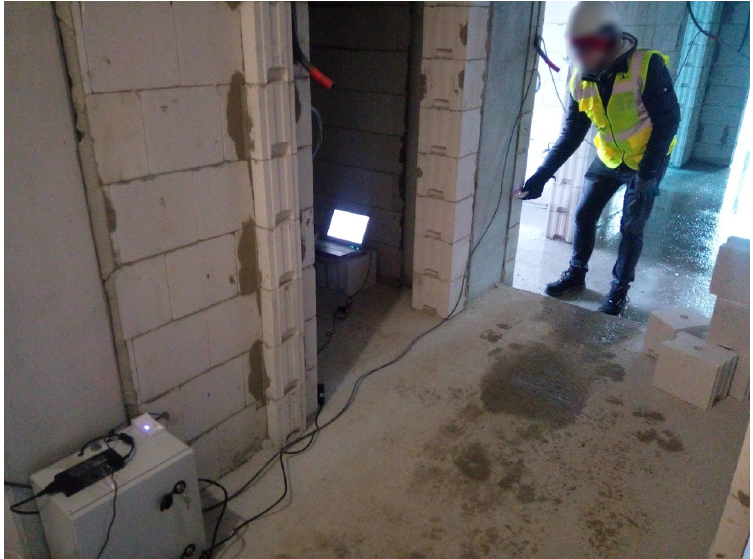
Figure 18. GWEN inside enclosure (bottom left) in a construction site